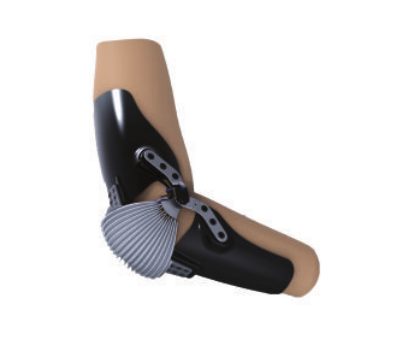
Figure 2: Elbow orthosis with shells made of ABS.